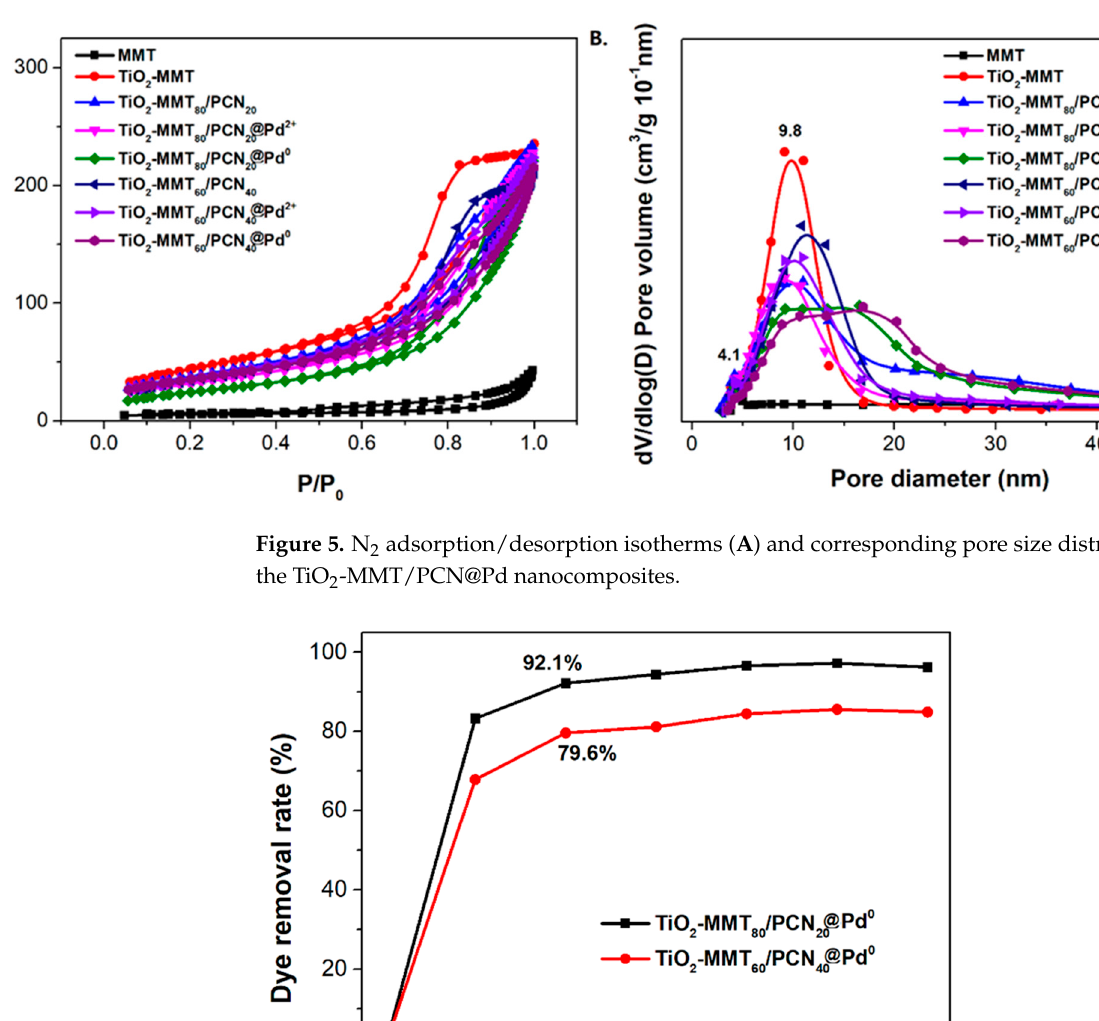
Figure 5. N 2 adsorption/desorption isotherms ( A ) and corresponding pore size distribution ( B ) of the TiO 2 -MMT/PCN@Pd nanocomposites. Table 1. Structural parameters of TiO 2 -MMT/PCN@Pd nanocomposites extracted from the iso- therms in Figure 5.